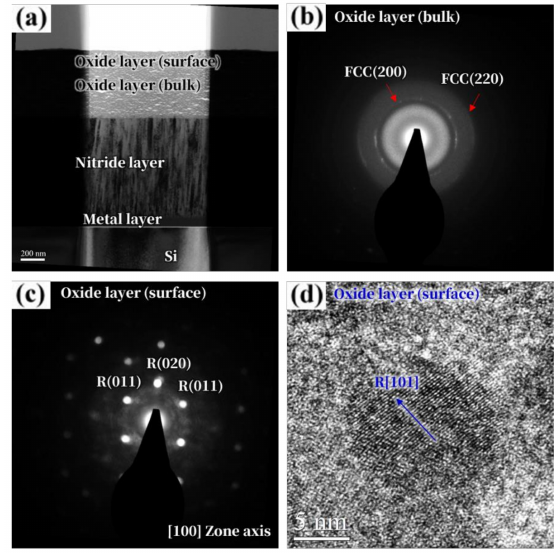
Figure 6. Cross-sectional TEM micrographs of the as-deposited (CrTaTiVZr)N coatings after annealing at 500 ◦ C in air. ( a ) bright-field image, ( b ) SAD pattern of the oxide bulk layer, ( c ) NBD pattern of the oxide surface layer, ( d ) HRTEM lattice image.